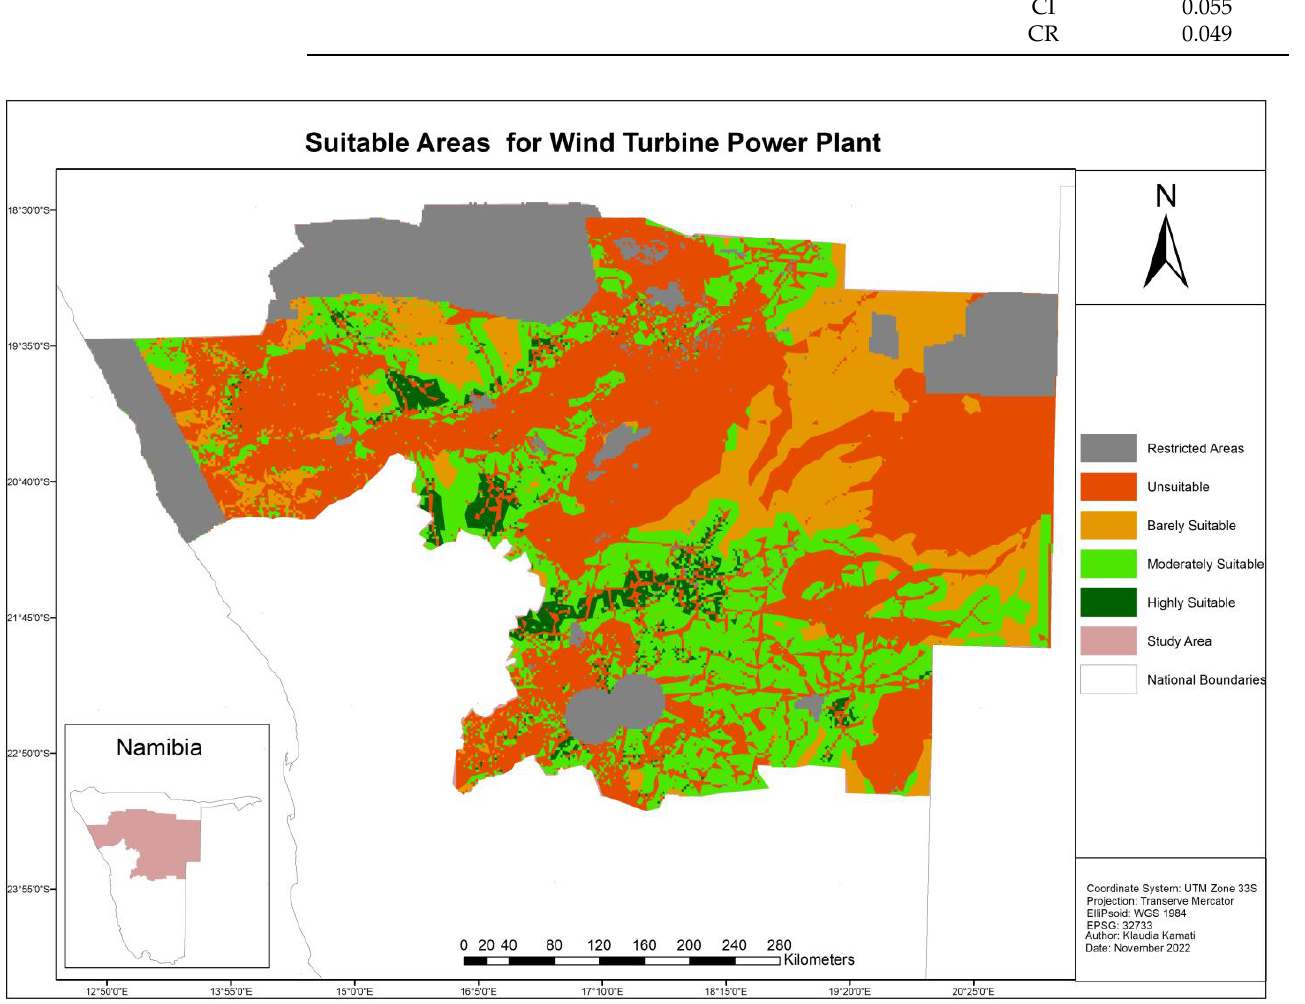
Figure 10. Wind turbine power plant suitability